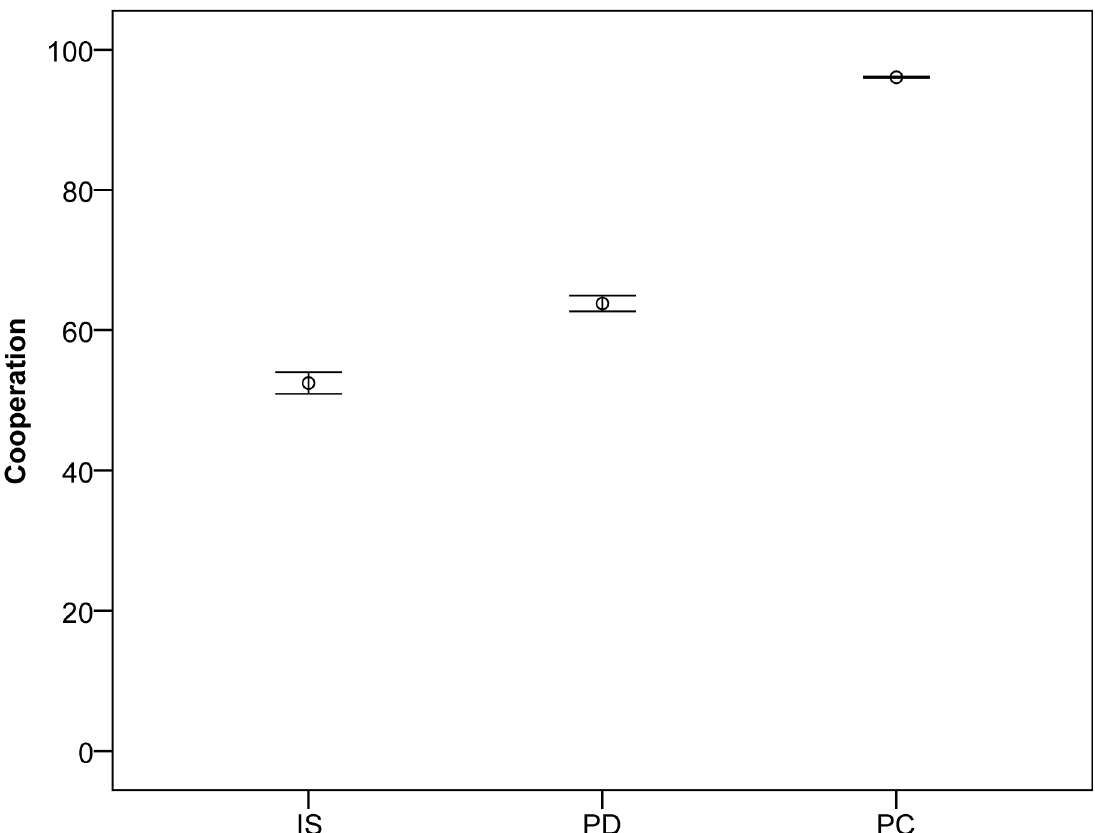
Fig 1. Cooperation with image scoring and partner choice. Percentage cooperation in simulations with pure image scoring with random assignment (IS); incorporating phenotypic defectors (PD); and with partner choice (PC). Cooperation is plotted as the mean ± SEM across 10 simulations of within simulation means each calculated across all 10,000 generations. One way ANOVA, F 2,27 = 422.42; p < 0.0005; post-hoc Scheffe comparisons all significant at 0.0005 level.